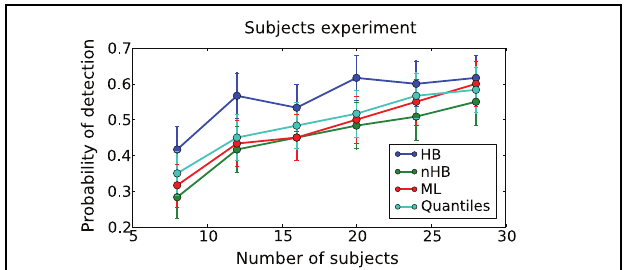
FIGURE 7 | Subjects experiment. Probability of detecting a drift-rate difference (y-axis) for different numbers of subjects (x-axis) and different estimation methods (color coded; HB, Hierarchical Bayes; nHB, non-hierarchical Bayes; ML, maximum likelihood; and Quantiles, χ 2 -Quantile method). HB together with Bayesian hypothesis testing on the group posterior results in a consistently higher probability of detecting an effect.